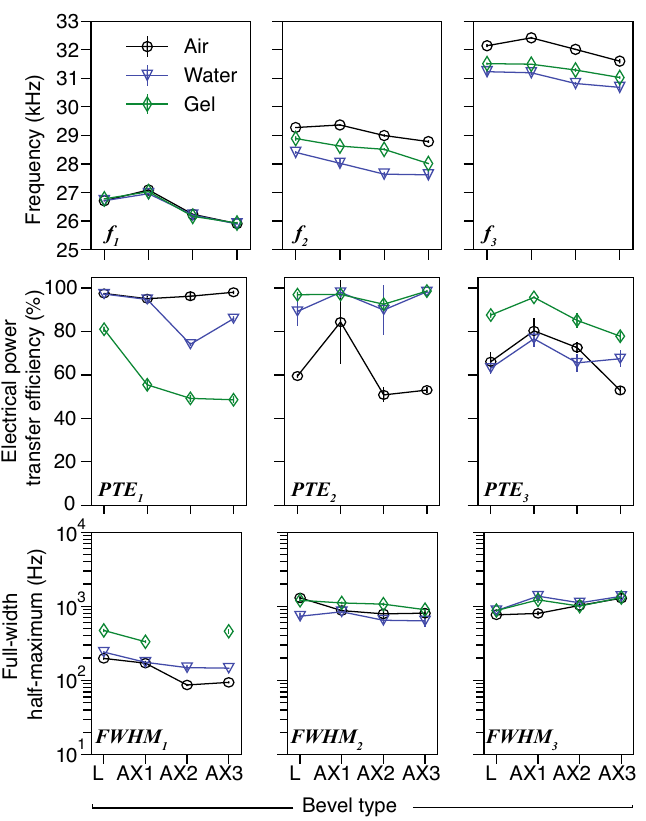
Figure 11. Analysis of the modal responses shown in Fig. 10 (mean ± s.d., n = 5), for bevels L and AX1–3, in air, water and gelatin 10% (depth 20 mm), featuring ( top ) three modal regions (low, middle and high), and their corresponding modal frequencies f 1 3 (kHz), ( middle ) power efficiency PTE 1 3 calculated using Eq. − − (4), and ( bottom ) the full-width at half-maximum measurements FWHM 1 3 (Hz), respectively. Note that the − measurement of bandwidth was omitted, when low PTE was recorded, i.e. in the case of bevel AX2, FWHM 1 . Mode f 2 was considered to be the most appropriate for comparing deflection of bevels, since it exhibited the highest levels of power transfer efficiency ( PTE 2 ), which were as high as